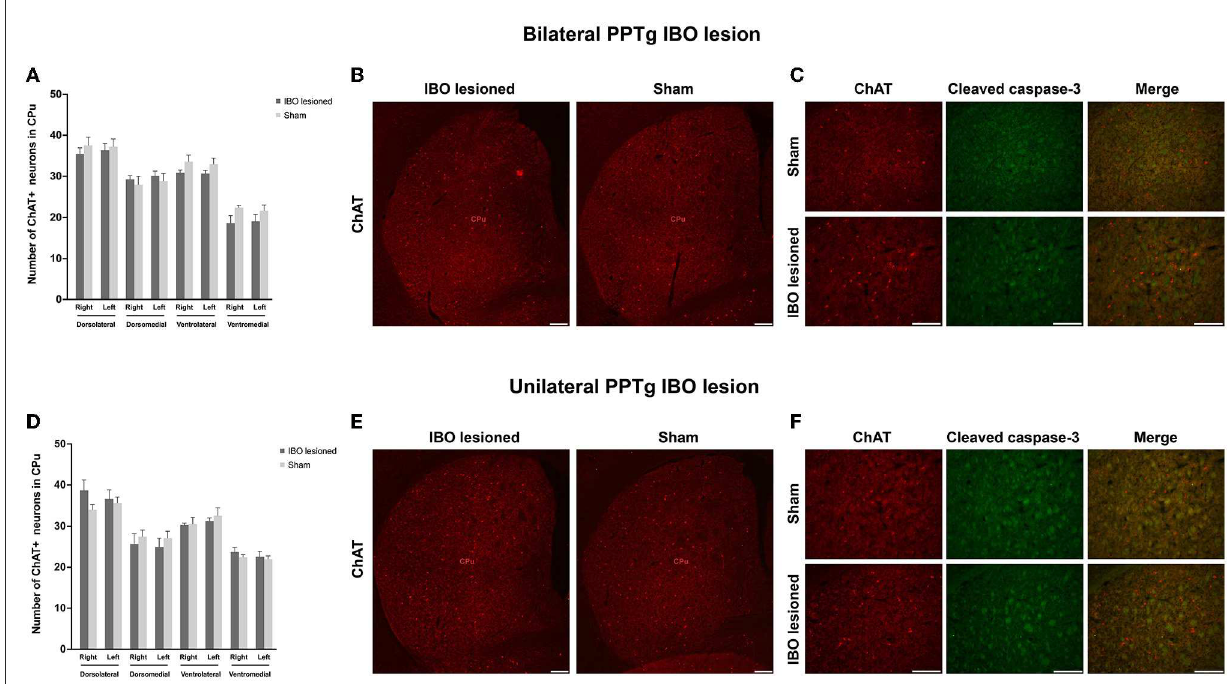
FIGURE8 PPTg IBO lesion did not induce cholinergic neuron loss and apoptosis in the CPu. There was no change in the number of cholinergic neurons (A, B) and apoptosis (C) in the CPu following the bilateral PPTg IBO lesion. In addition, there was no change in the number of cholinergic neurons (D, E) and apoptosis (F) in the CPu following unilateral PPTg IBO lesion. Scale bar = 1000 µ m. DL, dorsolateral; DM, dorsomedial; VL, ventrolateral; VM, ventromedial.